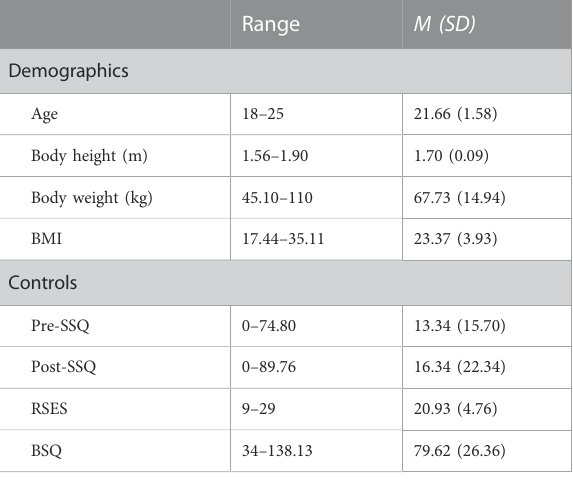
TABLE 1 Age, body measurements, and the scores of the control variables of our sample. Range M